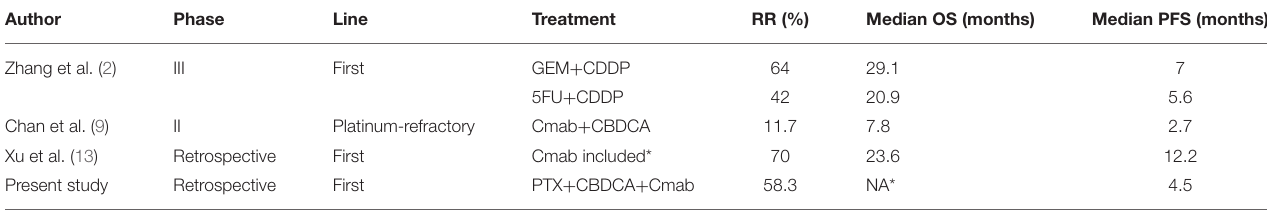
TABLE 5 | Palliative chemotherapy for R/M